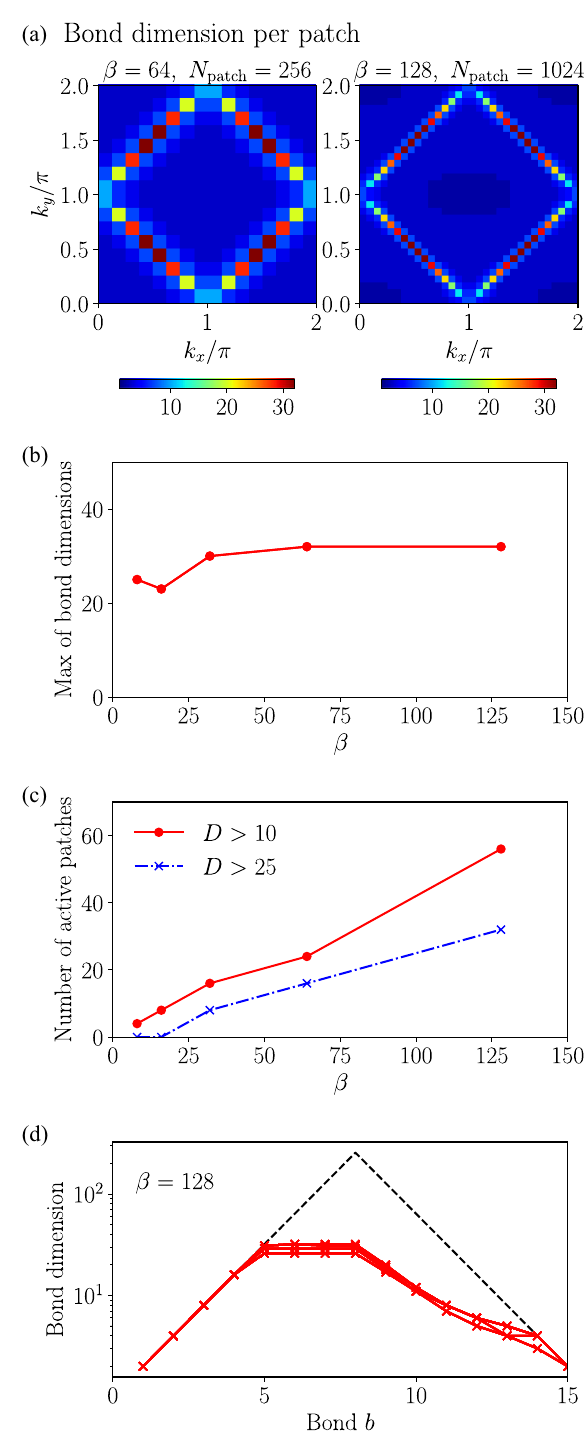
FIG. 10. Momentum dependence of the Matsubara Green ’ s function for the nearest-neighbor tight-binding model on the square lattice. (a) Bond dimensions per patch, (b) maximum value of the bond dimensions, (c) number of patches with large bond dimensions, and (d) bond dimensions along the chain for patches with relatively large bond dimensions ( ≥ 25 ). In (d), the dashed line indicates the maximum bond dimensions in maximally entangled